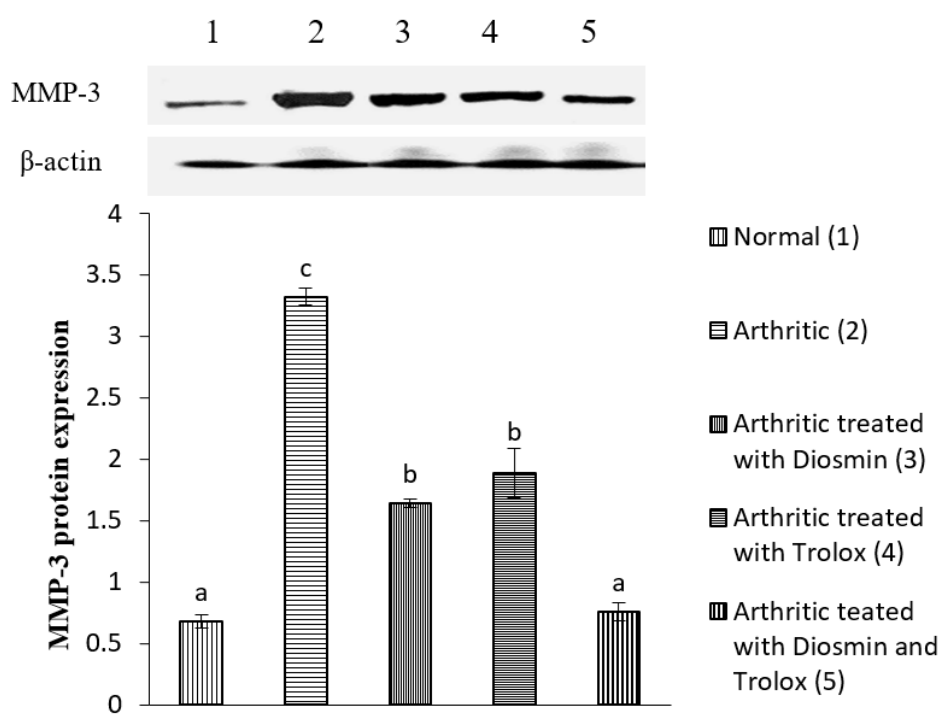
Figure 9. Effect of diosmin, trolox and their combination on MMP-3 protein expression level in CFA-induced arthritic rats. Means that have the same symbol (s) are not significantly different ( n = 3).